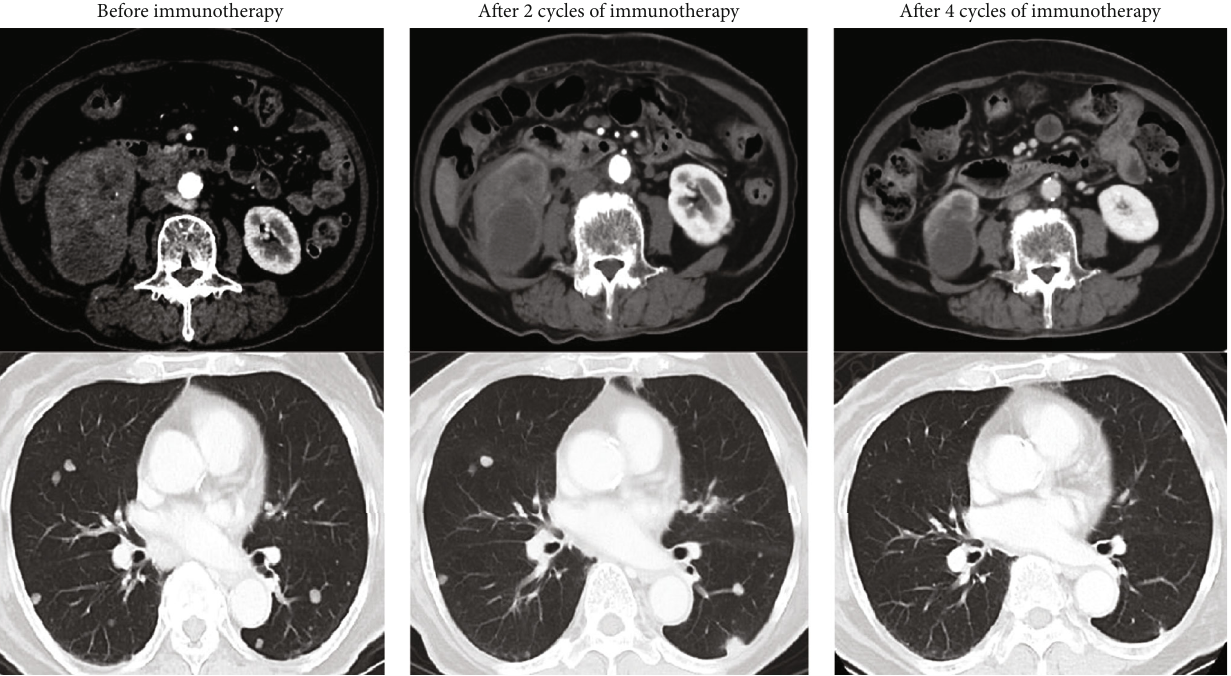
Figure 4: Computed tomography (CT) fi ndings in Case 2 showing new lesions in the lung after two cycles of immunotherapy, which shrank following the two additional